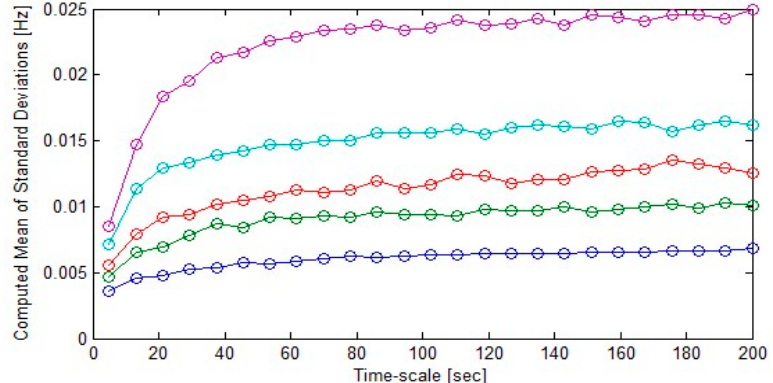
Figure 9. Frequency variability metrics for data shown in Figure 7, using different timescales. The colors correspond to the samples shown in Figure 7.